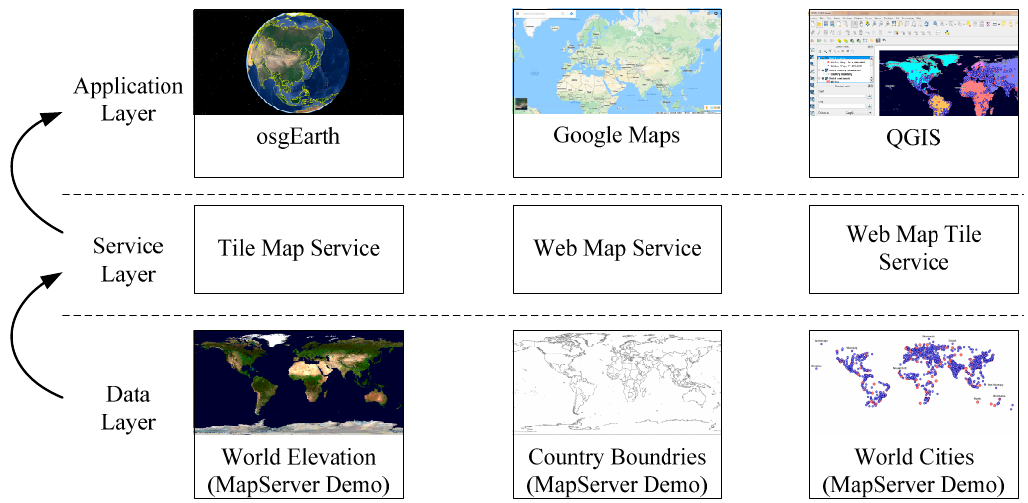
Figure 5. This shows the functional layers of online map services.